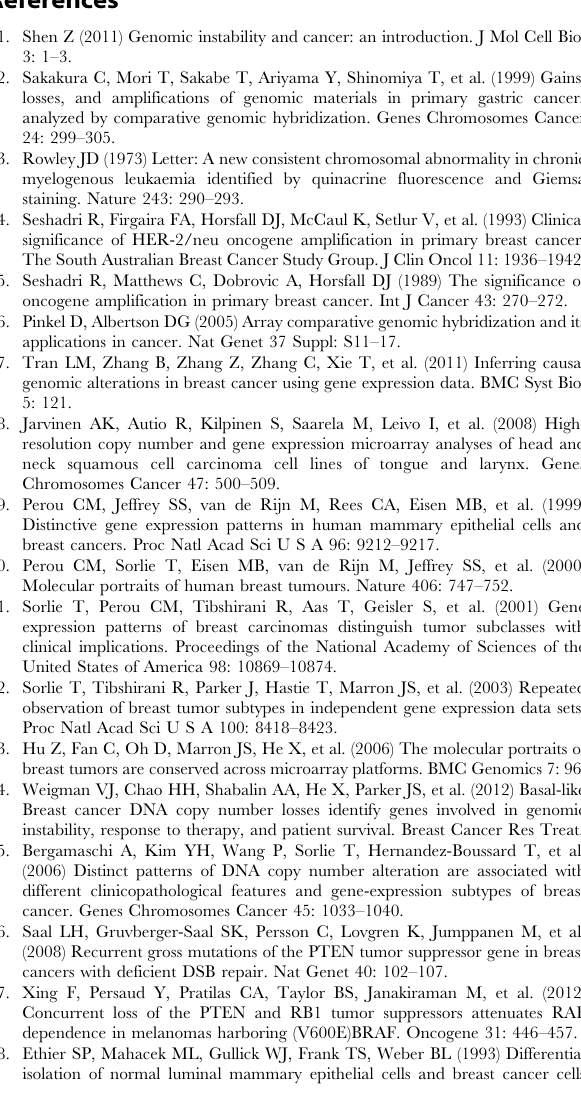
Table S2 Gene list, tiling array coverage, and analysis windows. List of the 128 genes on the tiling array with EntrezGene ID along with their genomic coordinates by NCBI build 36.1 (hg18) of the reference human genome. Coordinates are also provided showing the total coverage on the tiling array for each gene as well as the + / 2 5 kb analysis window that was used. Table S3 Micro-aberration information table. Table containing information on all micro-aberrations identified using the defined parameters described in this manuscript from the tiling